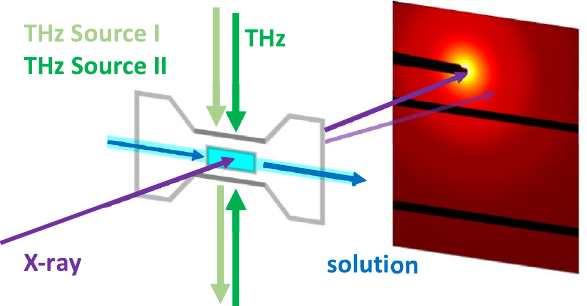
Figure 1. Schematic drawing of the THz-SAXS experiment on protein solutions. The monochromatic X-ray beam (purple arrow) is scattered from the protein solution (blue) flown through a microfluidic cell. Perpendicular to the X-ray beam path and to the flow direction, the solution is irradiated with THz-radiation. THz source I provides the exposure from one side (light green), while source II allows irradiation from both sides (dark green). Two-dimensional SAXS patterns are recorded by a PILATUS 6 M detector (zoom to the central part of the 2D detector image is